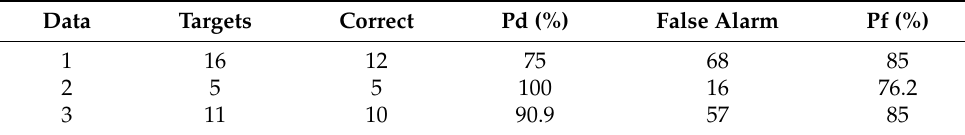
Table 3. Detection performance of the branch merging method.